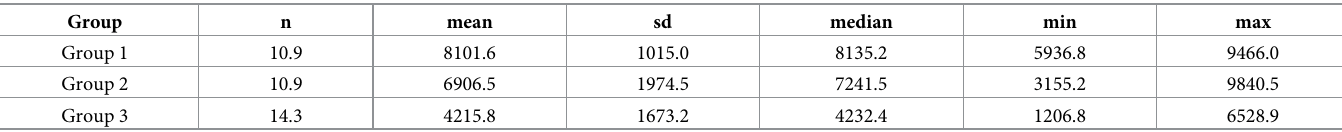
Table 1. Assessing variation within the groups—summary statistics—L4E workload units.